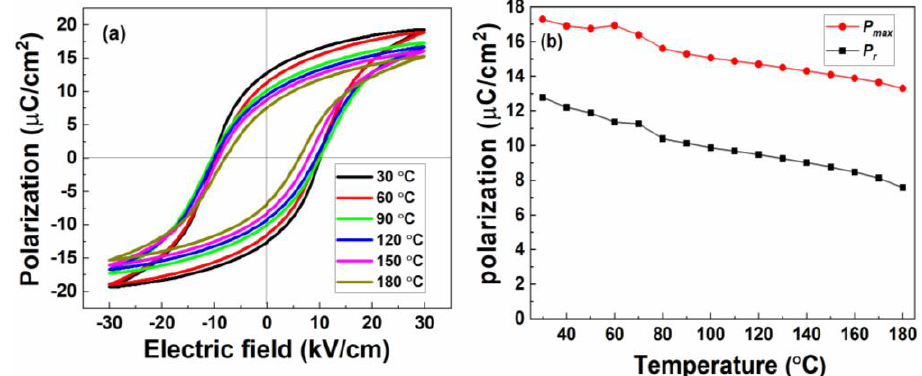
Figure 5. ( a ) Polarization – electric field ( P – E ) loops at different temperatures and ( b ) variation in its P max and P r with temperature for the 0.92KNLN − 0.08BZ ceramic prepared using the 3 − step/20 h